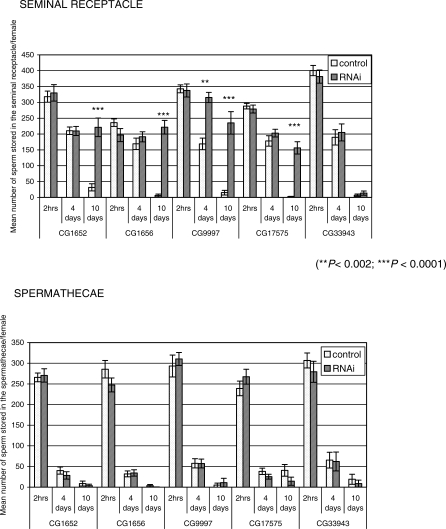
Number of Sperm Stored (Mean ± SE) in Seminal Receptacle or Spermathecae of Mates of CG1652, CG1656, CG9997, or CG17575 Knockdown Males (RNAi) Compared to their Controls at 2 h ASM, 4 d ASM, and 10 d ASM.(A) We did not detect a significant difference in the number of sperm stored by mates of CG1652, CG1656, or CG17575 knockdown males compared to their controls in the seminal receptacles at 2 h ASM (p > 0.25) or 4 d ASM (p > 0.2) but we observed significant difference at 10 d ASM (p < 0.0001). Mates of CG9997 knockdown males had sperm storage levels similar to their controls at 2 h ASM (p > 0.2) but at 4 d and 10 d ASM, the number of sperm stored in the seminal receptacle of mates of CG9997 knockdown males was significantly higher than their controls (p < 0.0001). (B) We did not detect significant difference in the number of sperm stored by mates of CG1652, CG1656, CG9997, or CG17575 knockdown males compared to their controls in the spermathecae at 2 h ASM (p > 0.2) or 4 d ASM (p > 0.2) or 10 d ASM (p > 0.5). Number of females ranged from 15–35 per treatment depending on the Acp analyzed or the storage organ counted.